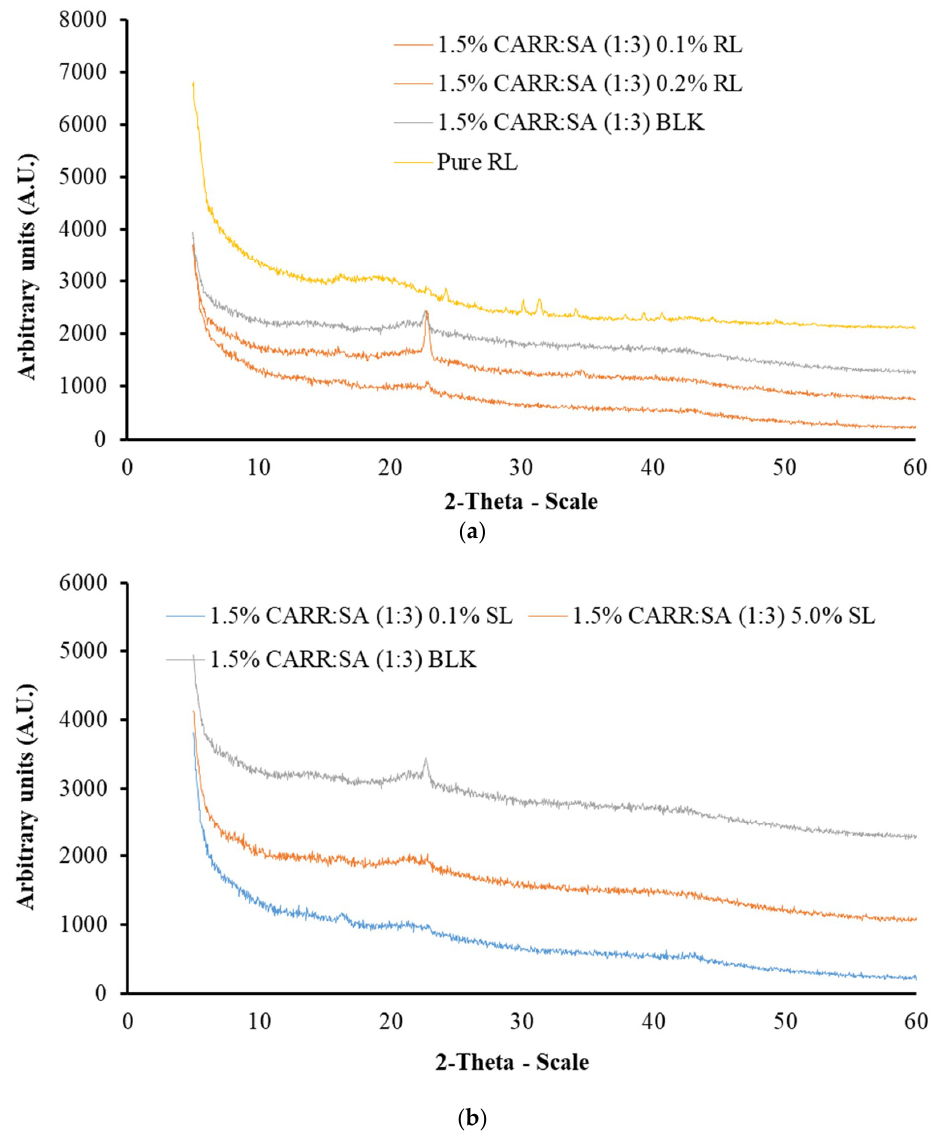
Figure 2. XRD diffractograms of ( a ) BLK and pure RL and RL loaded 1.5% CARR:SA (1:3) wafers and ( b ) BLK 1.5% CARR:SA (1:3) and SL loaded 1.5% CARR:SA (1:3) wafers.